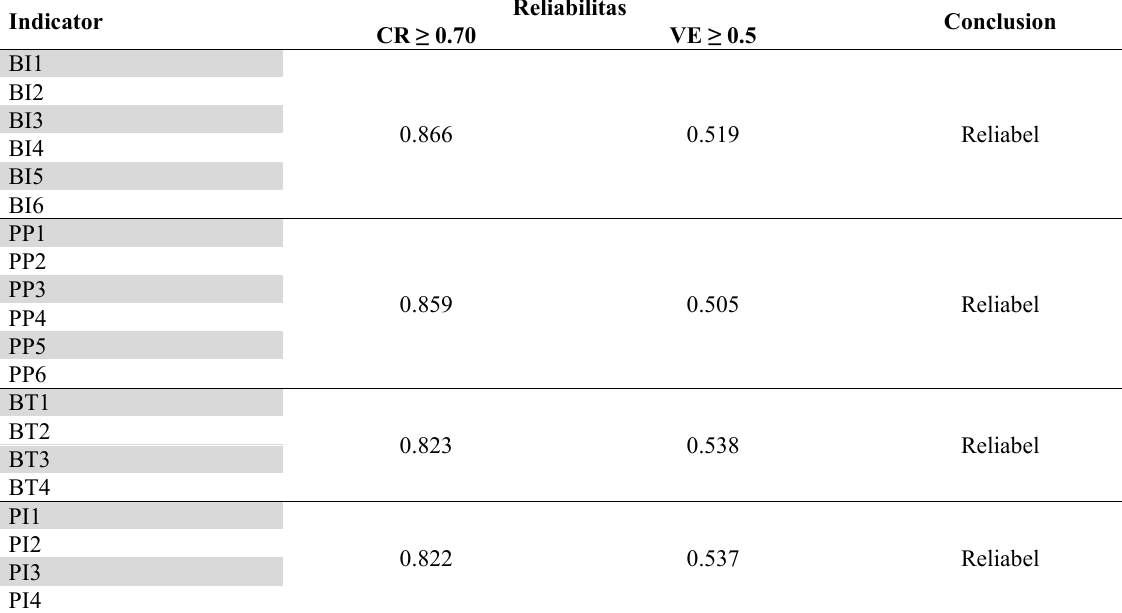
Construct Reliability and Variance Extracted